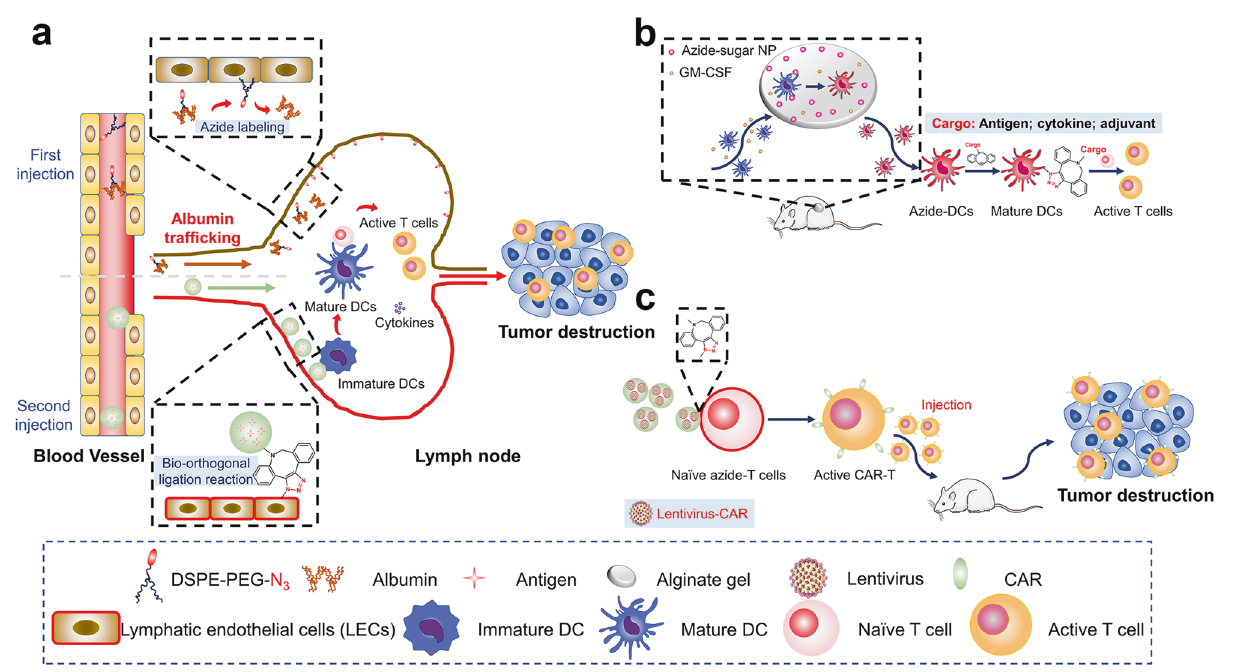
Fig. 4 Targeted delivery of immunomodulators to immune cells or immune organs. a Lymph node targeting of nanovaccine. b In situ DC targeting of antigen, cytokine, and adjuvant. c T cell targeting of lentiviral